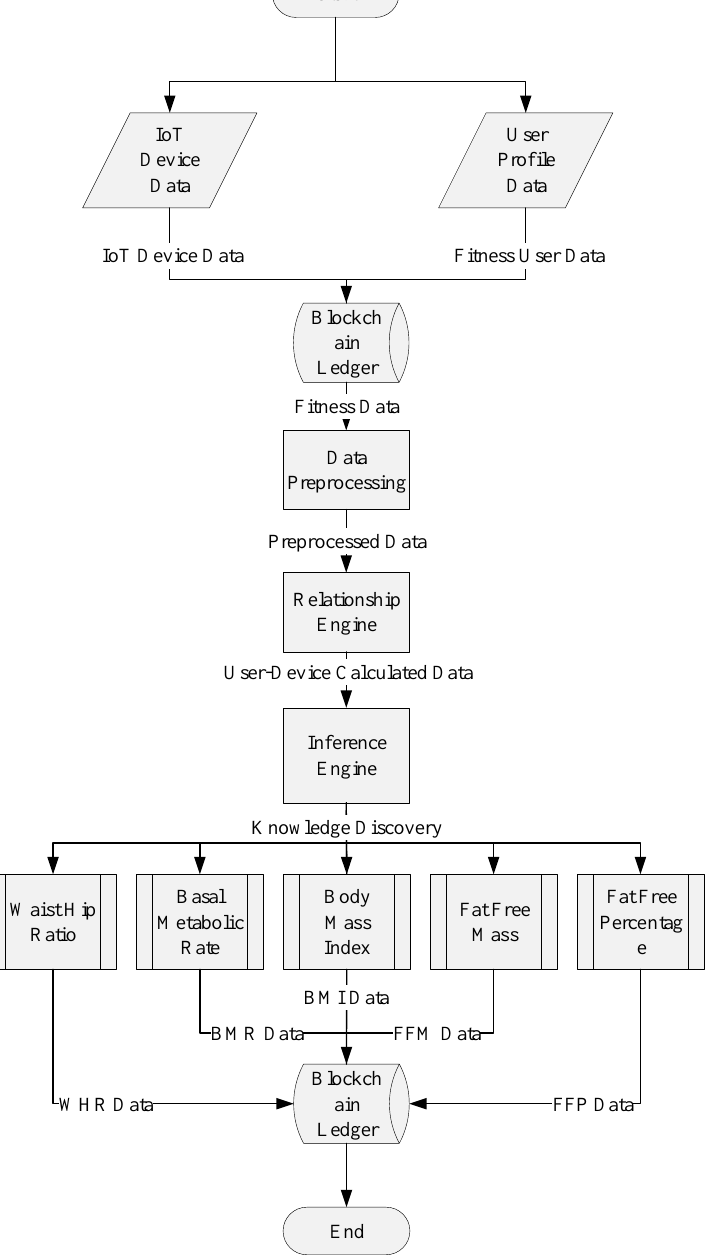
Figure 5. Flow chart of intelligent fitness service model based on enhanced smart contract enabled relationship and inference engine in IoT